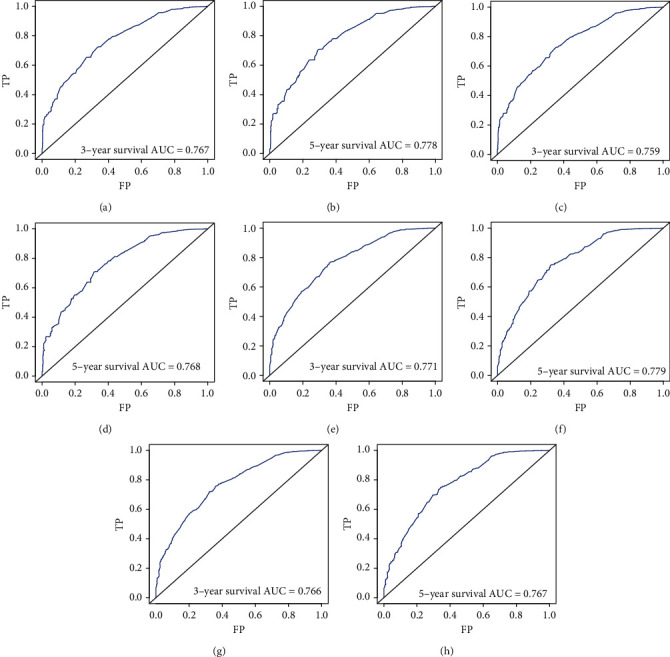
Calibration plots of the nomogram for 3- and 5-year OS (a, b) prediction in the training set, 3- and 5-year OS (c, d) prediction in the validation set, 3- and 5-year CSS (e, f) prediction in the training set and 3- and 5-year CSS (g, h) prediction in the validation set.